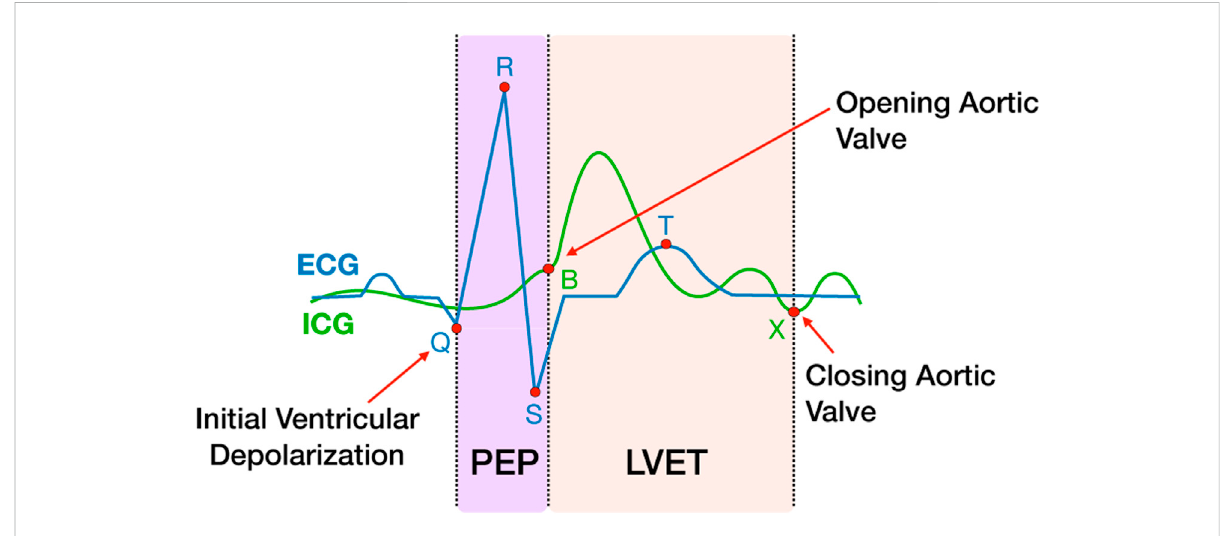
FIGURE 2 PEPandLVETmeasuresextractedfromICGandECGwaveforms.TheICGwaveform(greenline)isshownoverlappingtheECGwaveform(blue line). The ICG Band X points represent theopen and closing ofthe aortic valve, respectively. The Q point of theECG represents theinitial ventricular depolarization. The time interval between Q and B represents PEP, the sum of electromechanical delay and isovolumic contraction of the ventricle. LVET is the time interval between B and